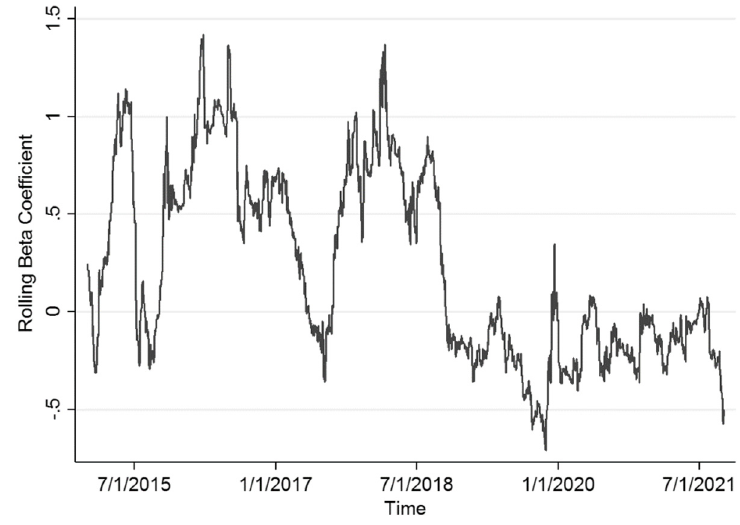
Figure 7. Common shock (rolling) impact on the BPER performance: period January 2015–December 2021. Source: authors calculations in Stata on Bloomberg data.